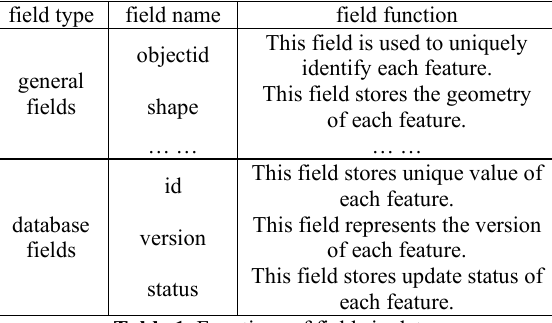
Table 1 . Functions of fields in